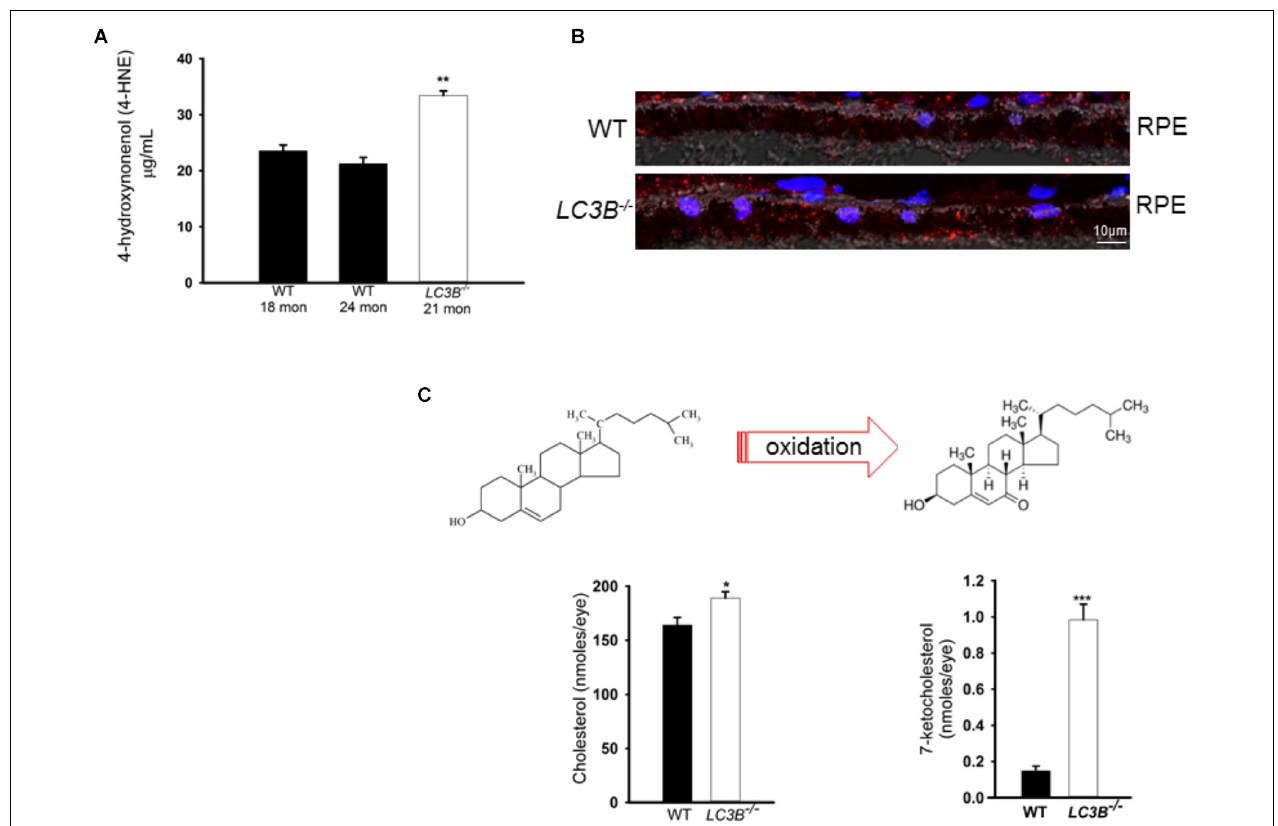
FIGURE 6 | (A) 4-HNE-adducts and 7-ketocholesterol accumulates in the L3CB − / − . (A) Level of 4-hydroxynonenol protein adducts measured by ELISA for WT and LC3B − / − RPE/choroid explants ( N = 6, ∗∗ p < 0.002). (B) Confocal image showing immunostaining for 4-HNE adducts (red) in 20 months old WT and L3CB − / − RPE, nuclei (blue), Ch-choroid. (C) B Levels of cholesterol and one of its oxidation products, 7-ketocholesterol in WT and L3CB − / − RPE explants measured by LC/MS. Values are mean ± SEM from 4 individual mice (average age 16 months), ∗ p < 0.050, ∗∗ p < 0.002, and ∗∗∗ p <